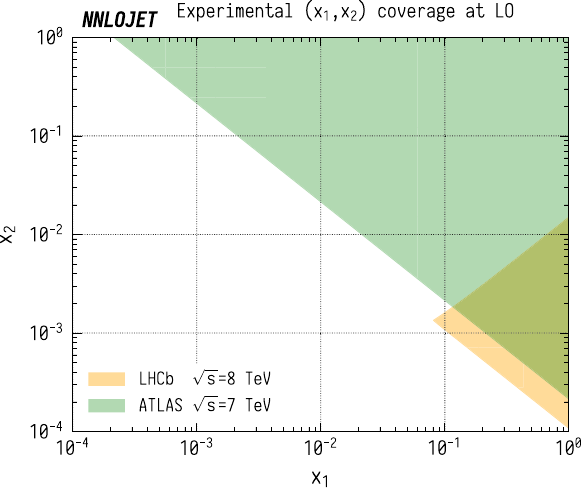
Fig. 2 The regions of the ( x 1 , x 2 ) plane accessible for the LHCb [16] and ATLAS [8] ZJ selection criteria at LO. Here x 1 and x 2 are the Bjorken-x values from beams 1 and 2